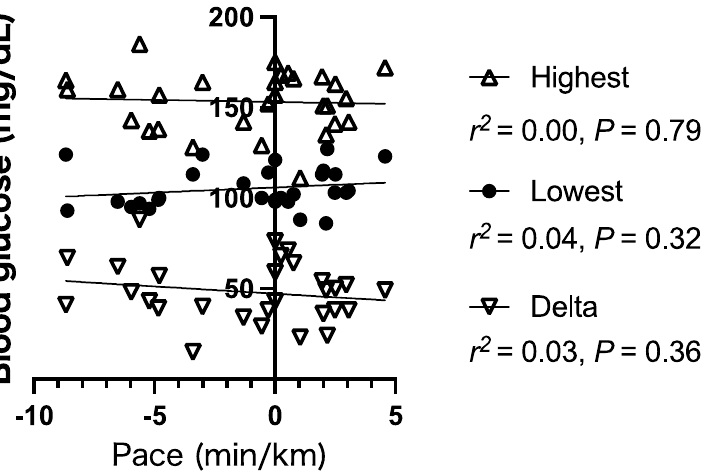
Figure 3. Relationship between the running pace and the highest blood glucose level, lowest blood glucose level, and delta (difference between the highest and lowest blood glucose levels) between segments. The pace was calculated from the difference between the estimated running time and actual running time of the segment, as described in the Methods section. Briefly, the pace value was positive when the runner ran faster than the estimated running time and negative when the runner ran slower.